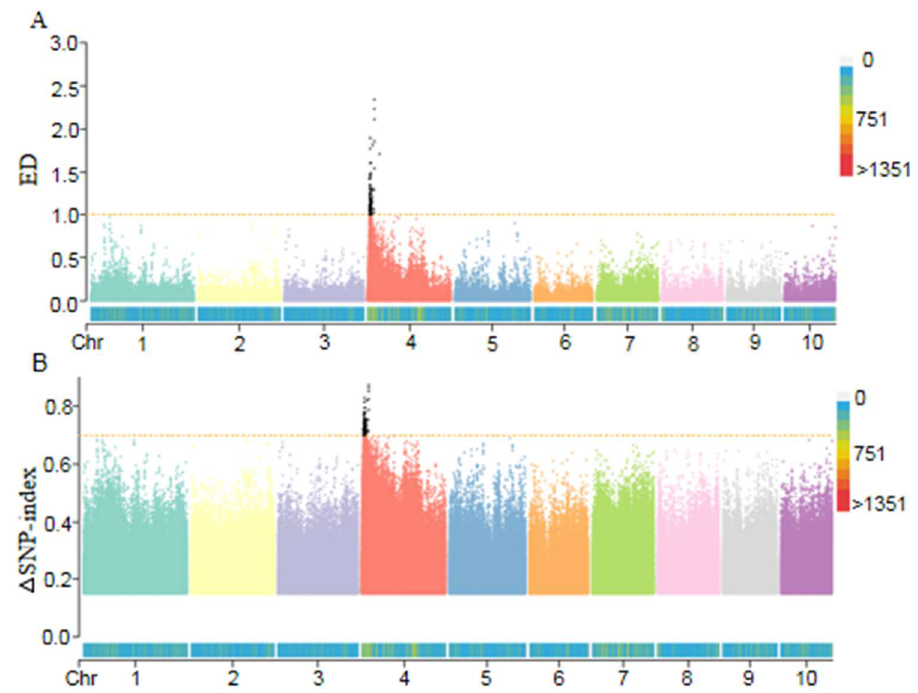
Figure 3. Mapping of the fea5 mutation using BSA-seq. ( A ) ED plot of the normal and fea5 pools. ( B ) ΔSNP-index plot of the normal and fea5 ear pools. The orange dashed line indicates the threshold.